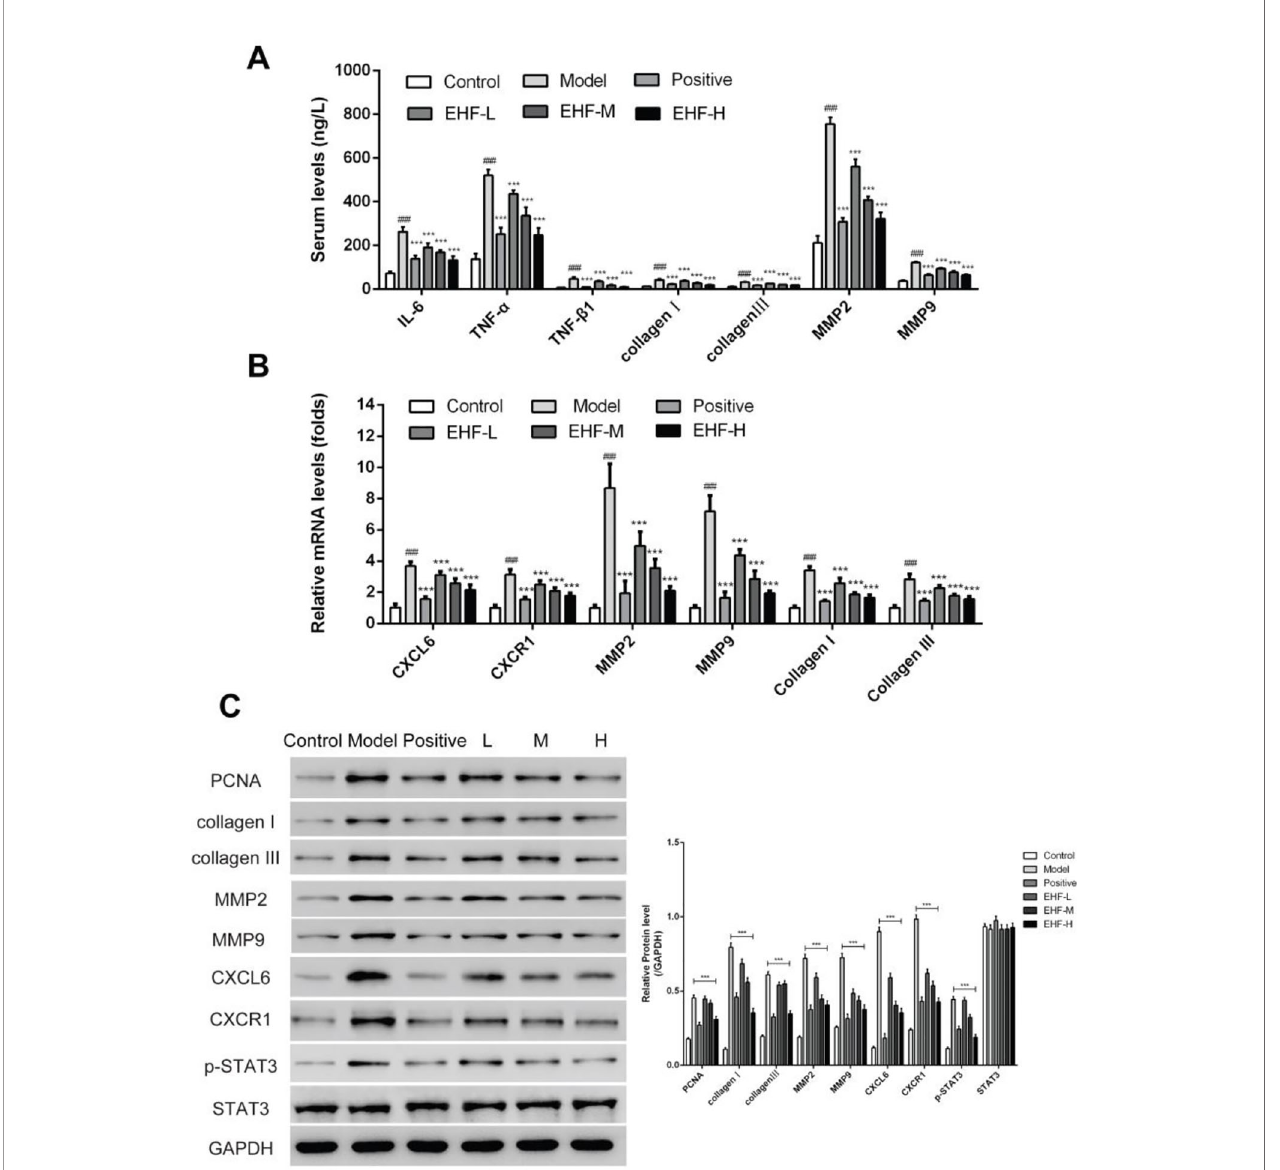
FIGURE 3 | EHF reduced the expression of in fl ammation and fi brosis related cytokines in DN rats. (A) The levels of several in fl ammation and fi brosis related cytokines in peripheral blood were measured by ELISA. (B) Relative mRNA expressions of several in fl ammation and fi brosis related cytokines were determined by qRT-PCR. (C) The protein levels of several in fl ammation and fi brosis related cytokines were examined by Western blotting. ***p < 0.001 versus model group, ### p < 0.001 versus control group. n =